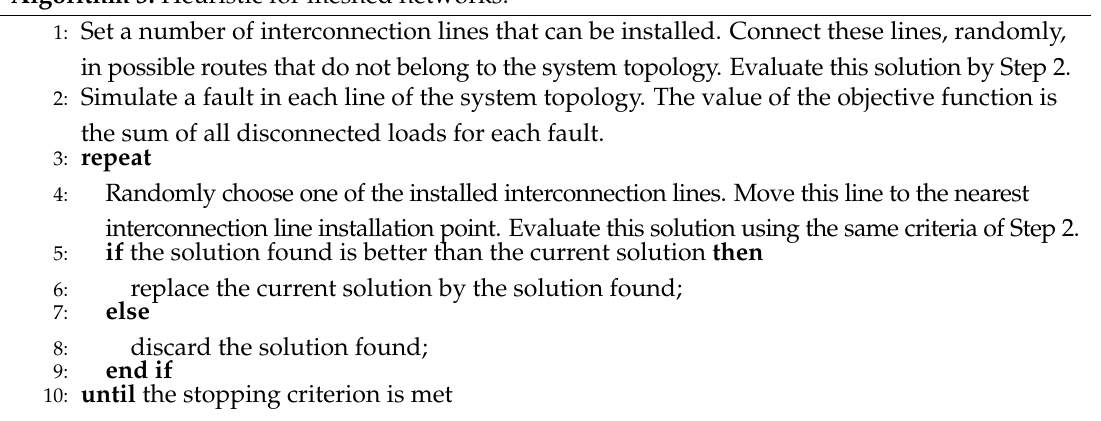
Algorithm 3: Heuristic for meshed